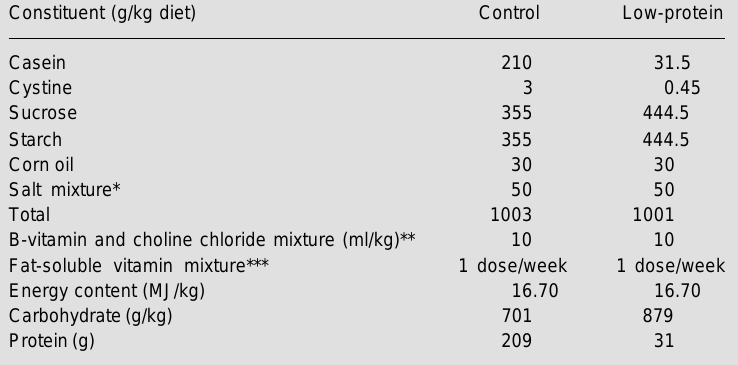
Table 1 - Composition of the control and low-protein diets given to